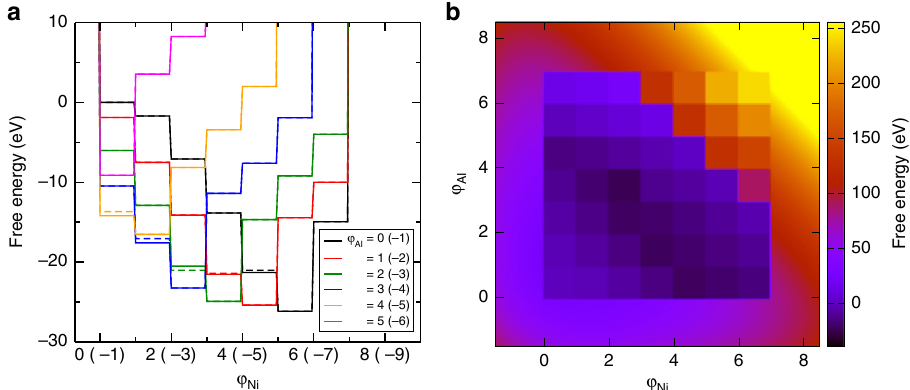
Fig. 4 Free energy plot. a Plot of free energy versus φ Ni for φ Al = 0 (black), 1 (red), 2 (green), 3 (blue), 4 (yellow), and 5 (magenta). b 2D plot of free energy as a function of φ Ni and φ Al . The dotted lines in ( a ) represent the free energy values for the no vacancy clusters in the bcc